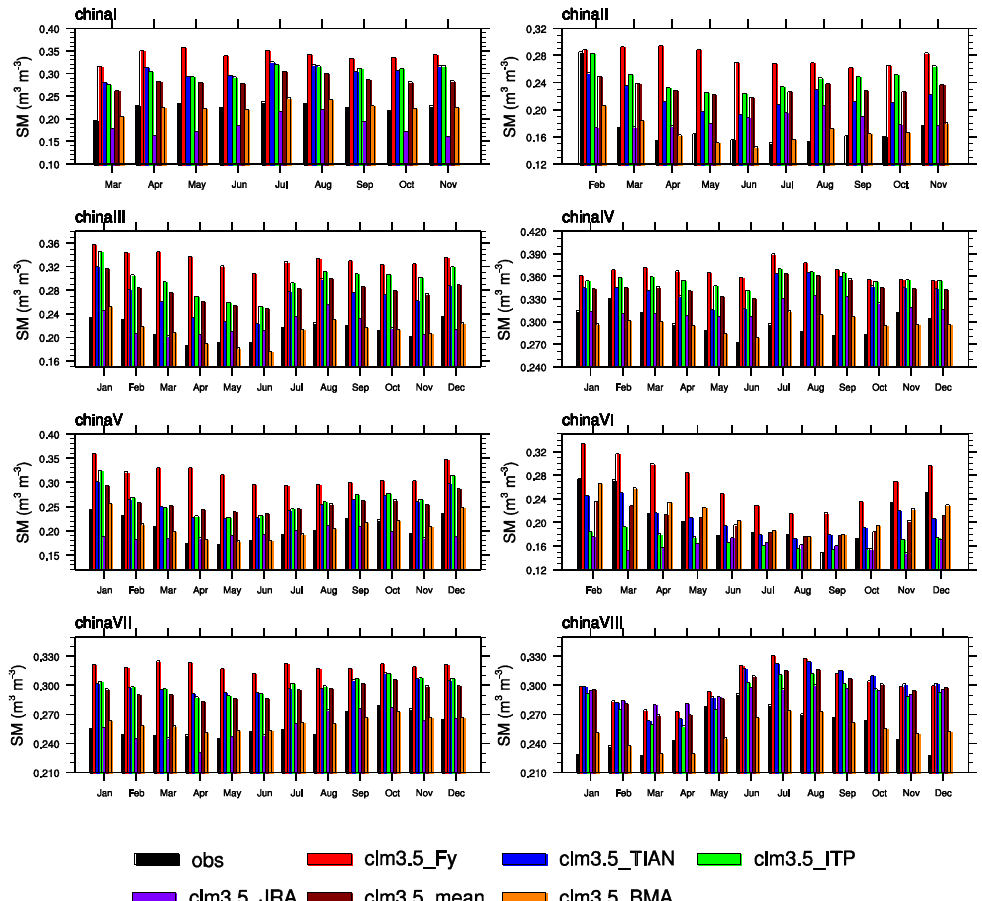
Fig.7. July 2005 – June 2010 mean monthly volumetric soil moisture (SM, m 3 .m –3 ) for 712 the 0–10 cm soil layer from observations, CLM3.5_FY, CLM3.5_TIAN, CLM3.5_ 713 simulated and observed monthly volumetric soil